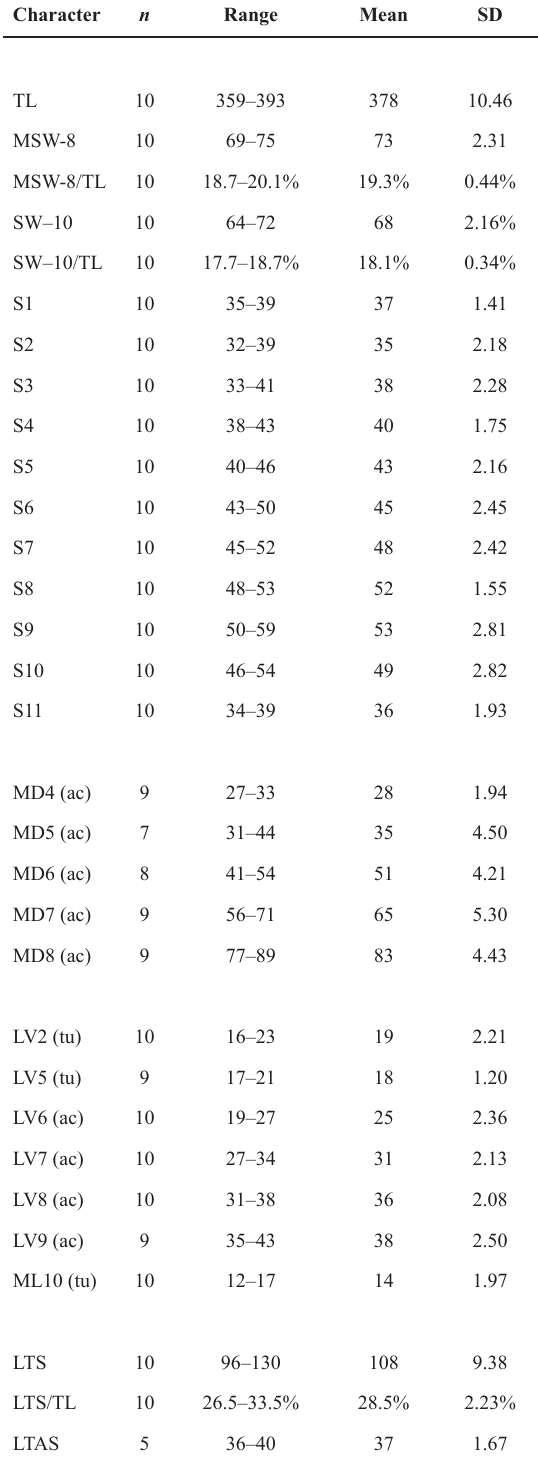
Table 7. Measurements from light microscopy for holotype and nine paratypes of Echinoderes pacificus Schmidt, 1974 from Galapagos Islands (in µm), including number of measured specimens ( n ) and standard deviation